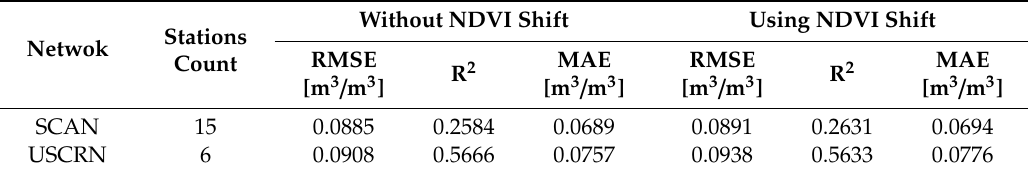
Table 3. Validation metrics of the produced high-resolution soil moisture obtained by using SCAN and USCRN soil moisture stations